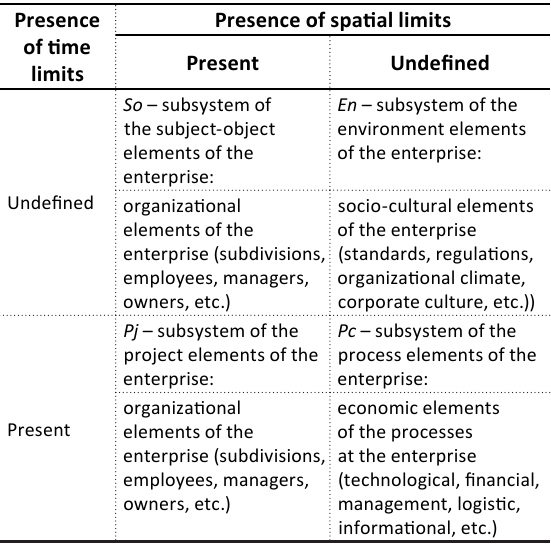
Table 1. Division of structural-functional elements of the enterprise by the